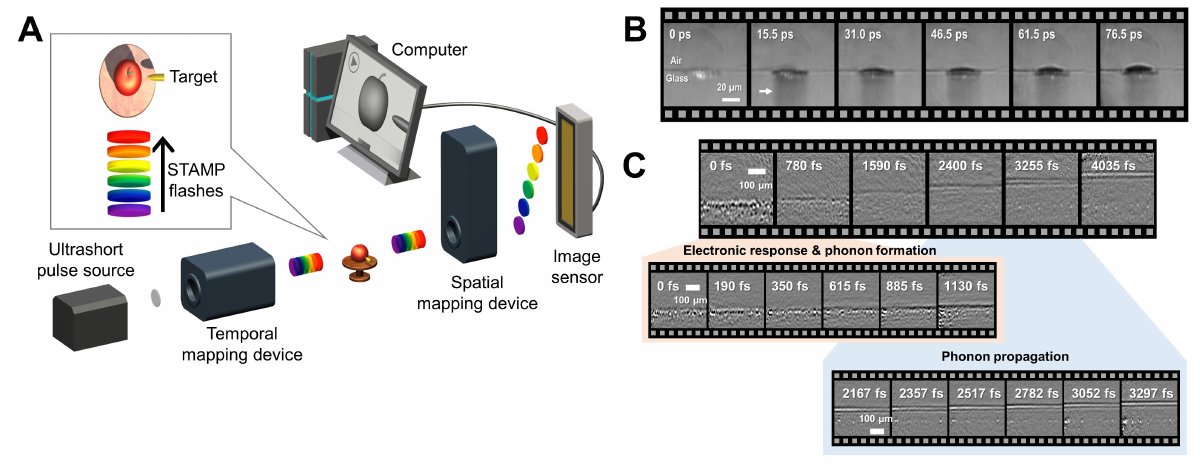
Fig. 5. STAMP. (A) Schematic. (B) Imaging of plasma dynamics with STAMP. (C) Imaging of phonon dynamics with STAMP. ©Figure courtesy of Ref.